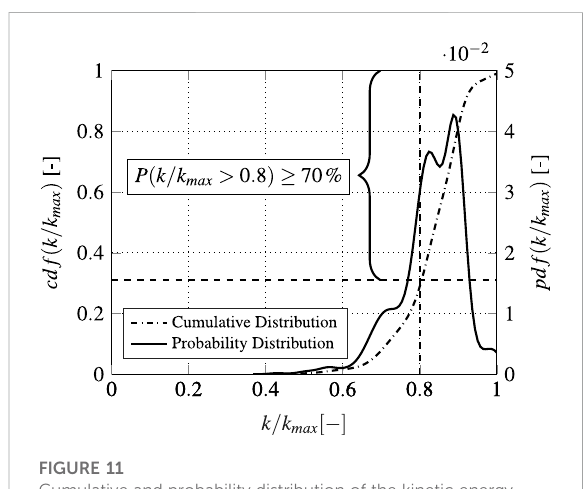
FIGURE 11 Cumulative and probability distribution of the kinetic energy deviation for all particles within the measurement plane for plate inclination angle β = 90 °